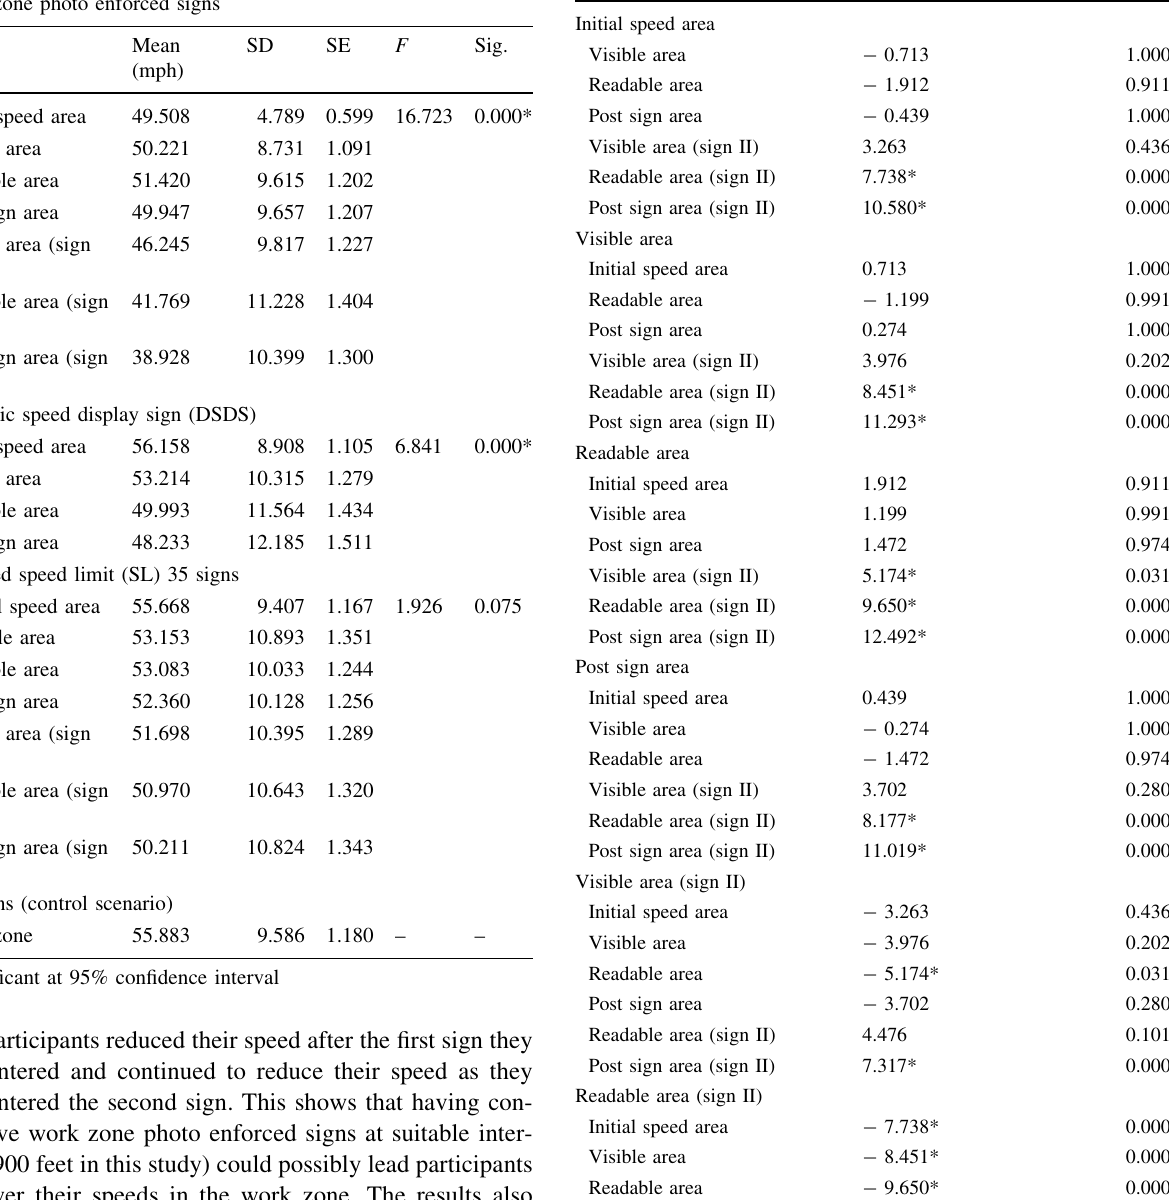
Table 2 Descriptive statistics and ANOVA of different phases by sign Work zone photo enforced signs